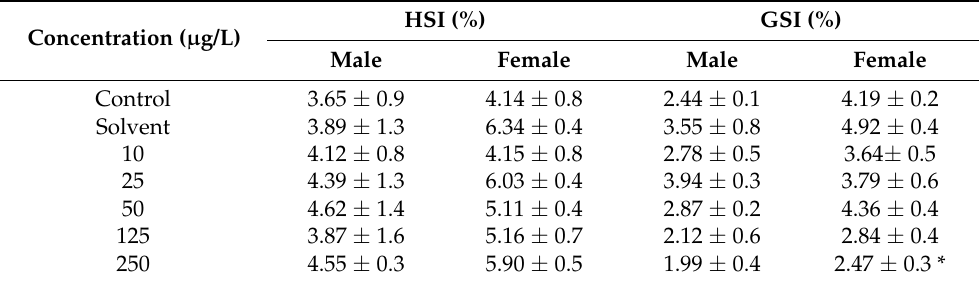
Table 2. Hepatosomatic (HSI) and gonadosomatic (GSI) of Javanese medaka (n = 3) at 21 days post-exposure to sublethal concentration of 3,4-DCA.